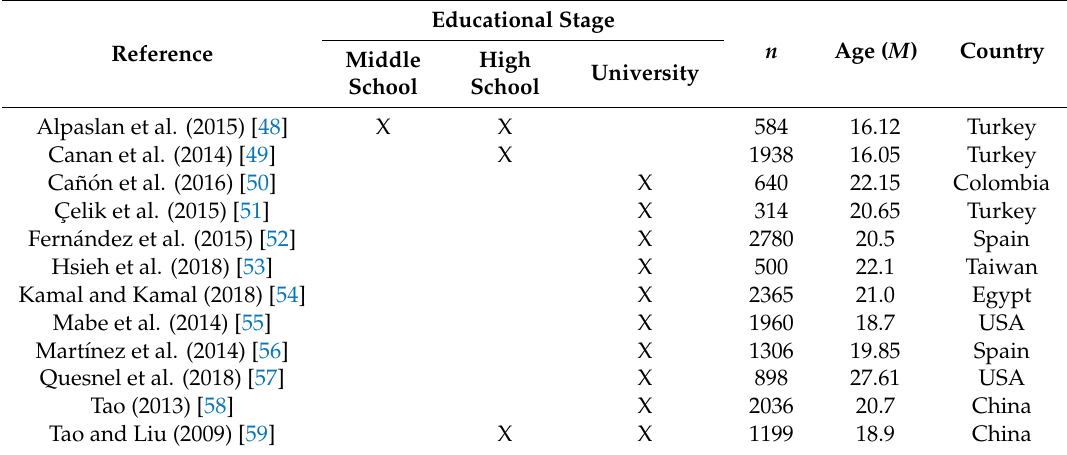
Table 3. Characteristics of the students.